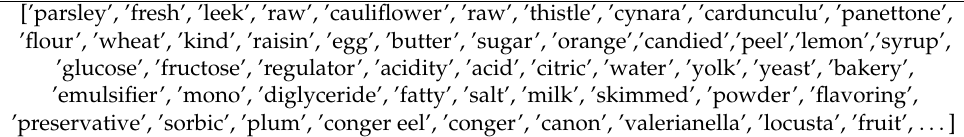
Table 6. Extract from all _ products _ words